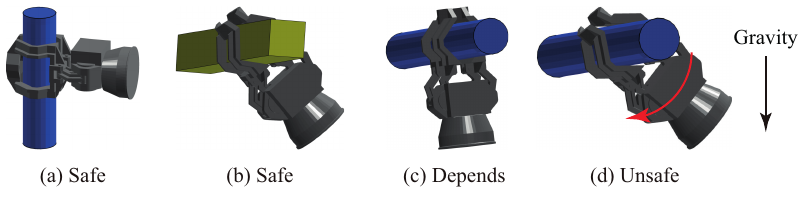
Figure 6. Four categories of